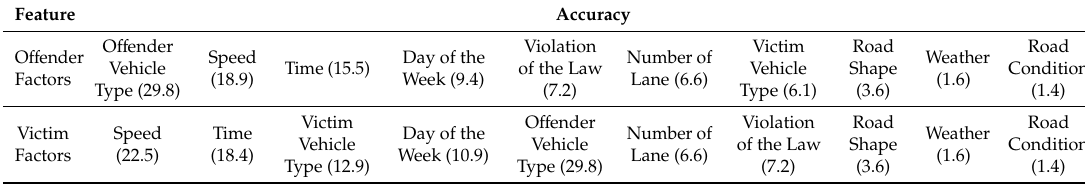
Figure 3. ( a ) Offender Injuries Accuracy by Optimal DNNs; ( b ) Victim Injuries Accuracy by Optimal DNNs: The red dash line rectangular stands for the highest accuracy at that factors. Table 8. Result of Importance Analysis for Tra ffi c Accident Table 7. Offender/Victim Injuries Prediction Accuracy using optimal DNNs model.